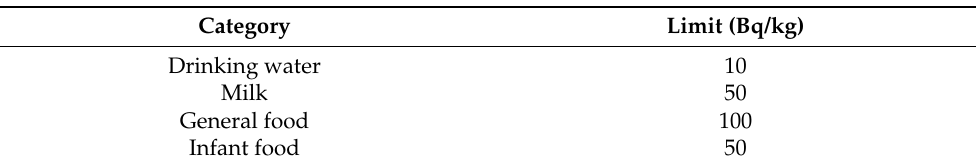
Table 1. Current criteria for radioactive cesium (sum of Cs-134 and Cs-137) in foods in Japan (established on 1 April